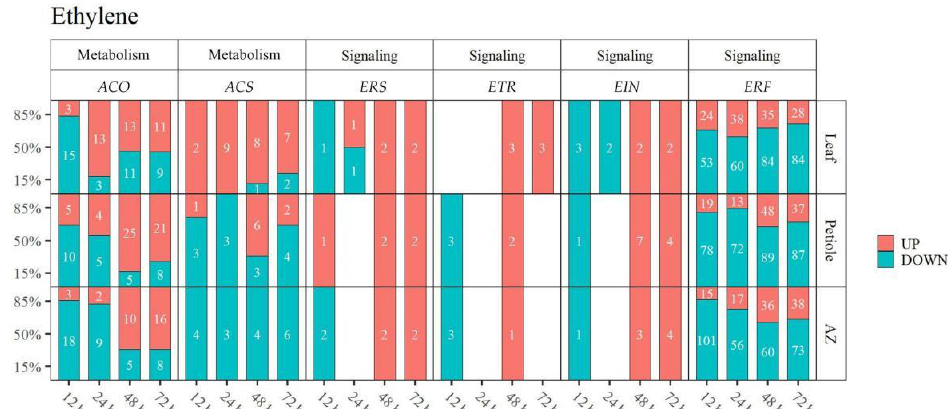
Figure 7. TDZ regulates the gene expression of ethylene metabolism and signal. DEGs were deter- mined between 12 h and 0 h, 24 h and 0 h, 48 h and 0 h, 72 h and 0 h, respectively. The DEGs were controlled by FDR < 5% and |log2Fc| ≥ 1. White digits indicate the gene numbers.